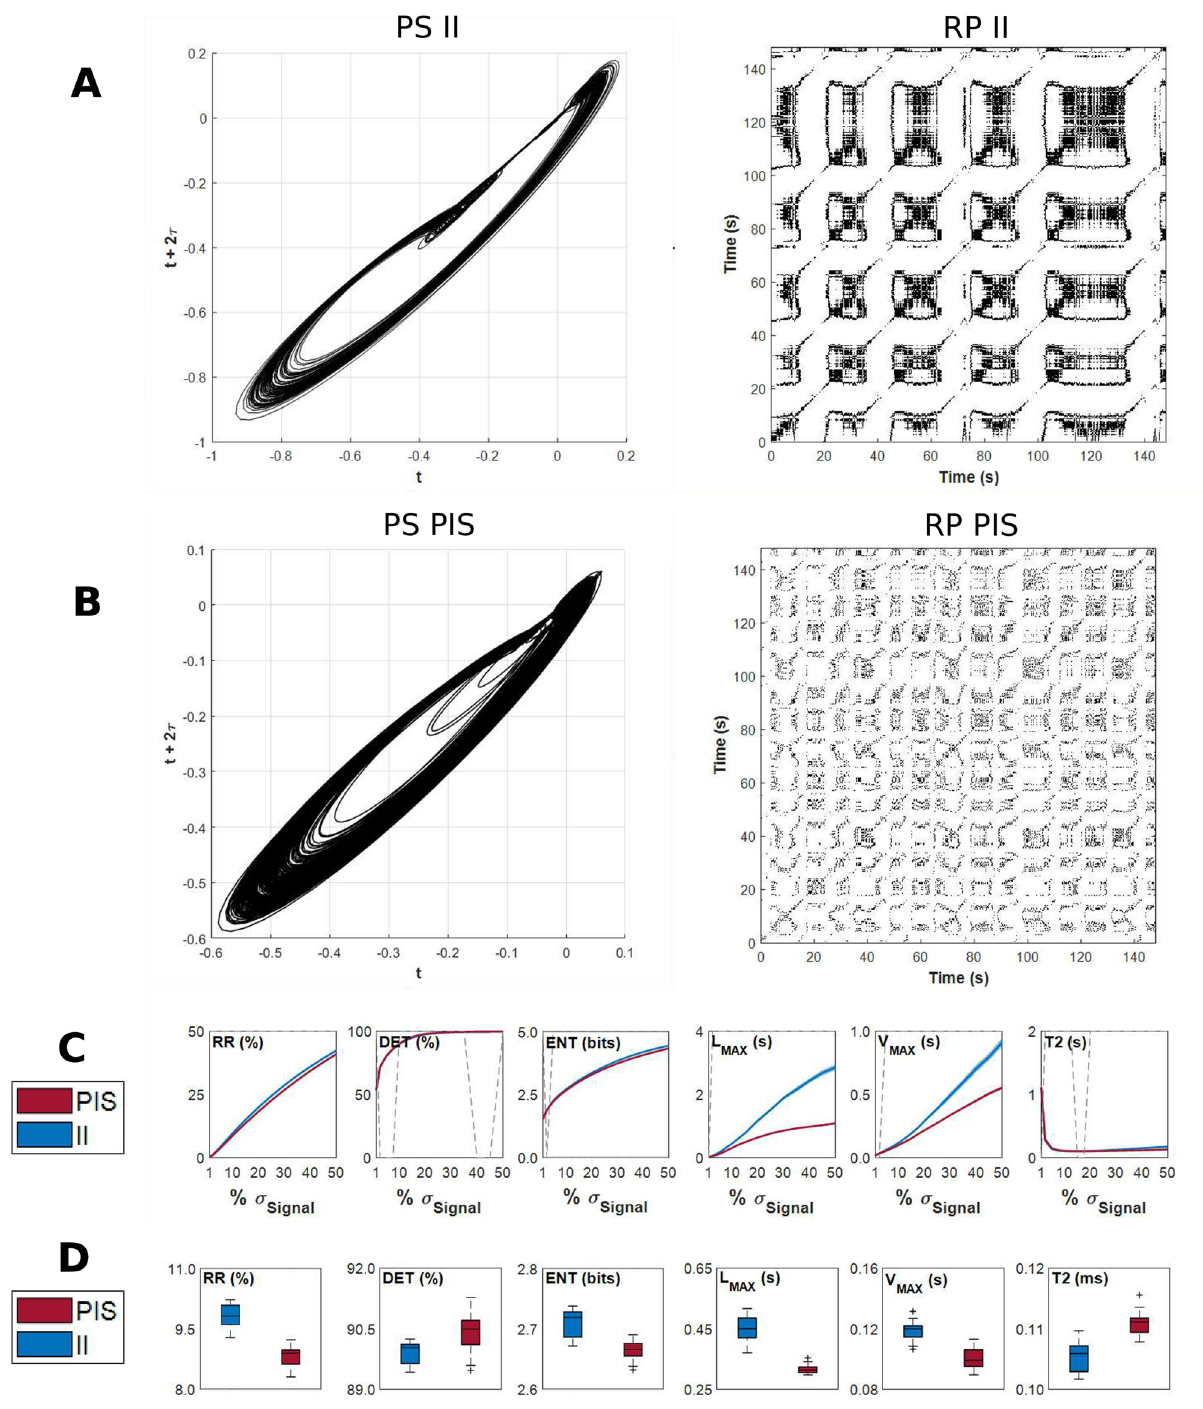
Fig 6. Dynamical characteristics of epileptiform-like activities in different time scales. Examples of phase space (left panel) and Recurrence Plots (right panel) of (A) interictal-like events and (B) periodic ictal spiking epileptiform activity, from time series recorded on dentate gyrus. (C) RQA factors in function of the recurrence threshold ( � ) parameter. The parameter � used to calculate Recurrence Plots was variated from 1% to 50% of the standard deviation of each electrophysiological record, with steps of 2.5%. The six RQA factors allow to compare II and PIS activities according to their levels of chaoticity, stochasticity and determinism. The dotted gray line indicates the regions where the RQA factors are statistically different ( p < α ) among both epileptiform activities, II and PIS, using Wilcoxon test (0’s means p > α ). (D) Distribution of RQA factors considering recurrence threshold as 10% of the standard deviation of each electrophysiological record. Each point of the boxplot was calculated into RPs constructed from windows of 10 s of the electrophysiological data analyzed (as RPs shown in (A) and (B)).